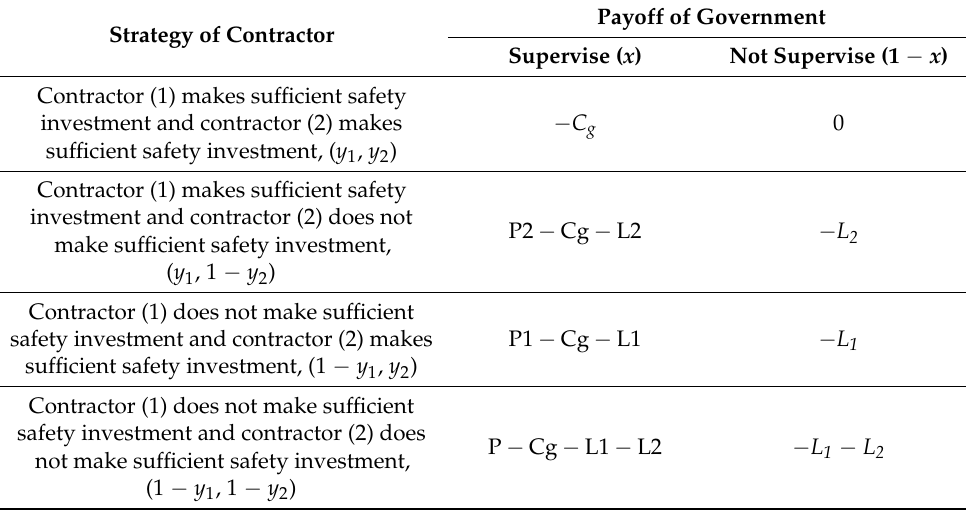
Table 3. Payoff matrix of the government supervision departments with the two